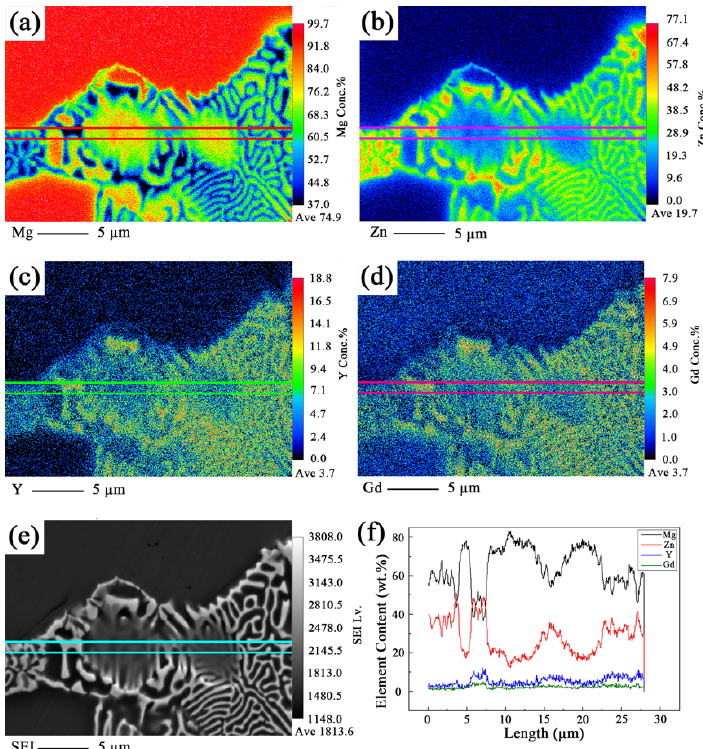
Figure 9. EPMA results of the Mg–10Zn–6.8Gd–4Y alloy after an isothermal heat treatment for 15 min: ( a ) Mg content distribution; ( b ) Zn content distribution; ( c ) Y content distribution; ( d ) Gd content distribution; ( e ) SEI image; ( f ) summary of element content distribution.